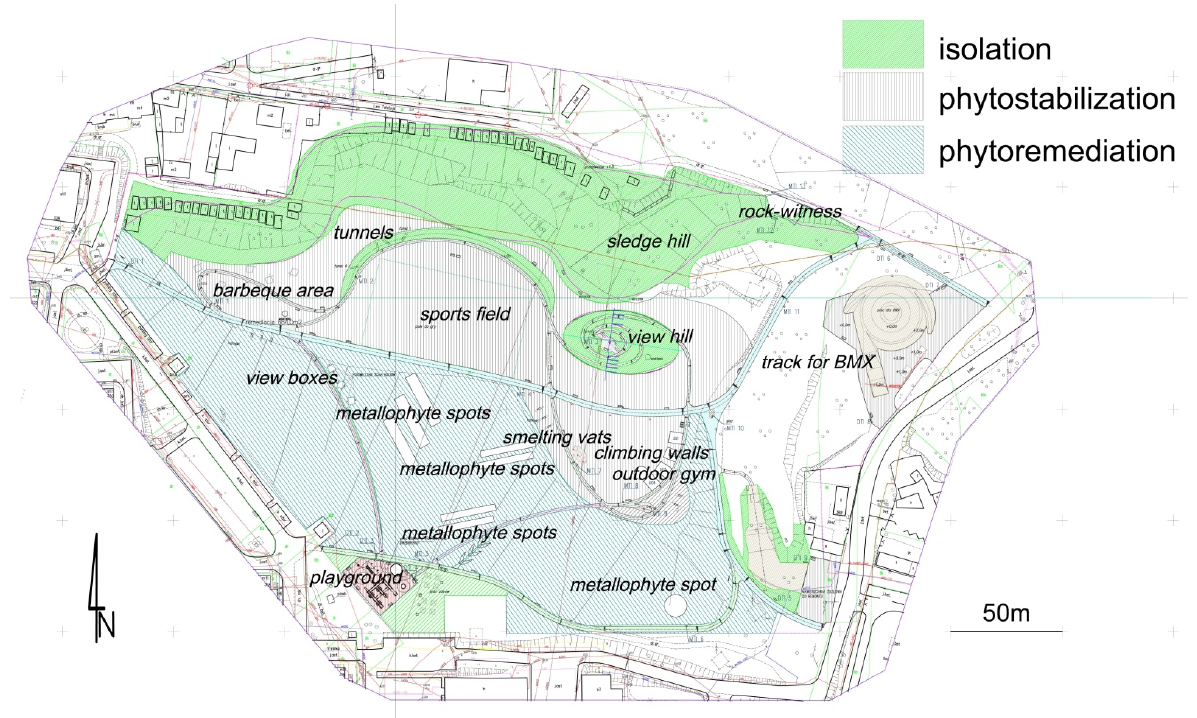
Figure 6. The Antonia Hill design, Ruda Ś l ą ska, Poland.